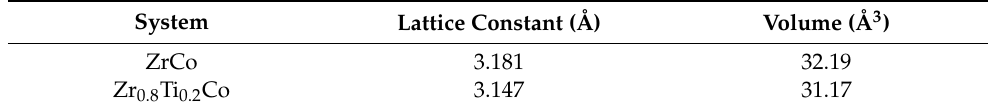
Table 3. Structural optimization data of ZrCo and Zr 0.8 Ti 0.2 Co alloys.